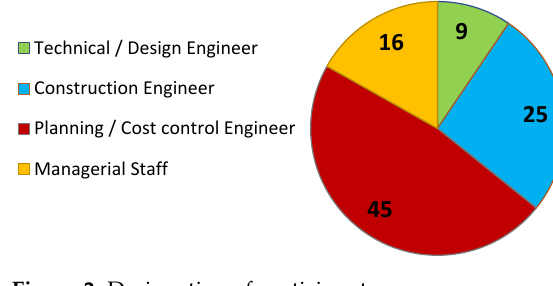
Figure 2. Designation of participants.